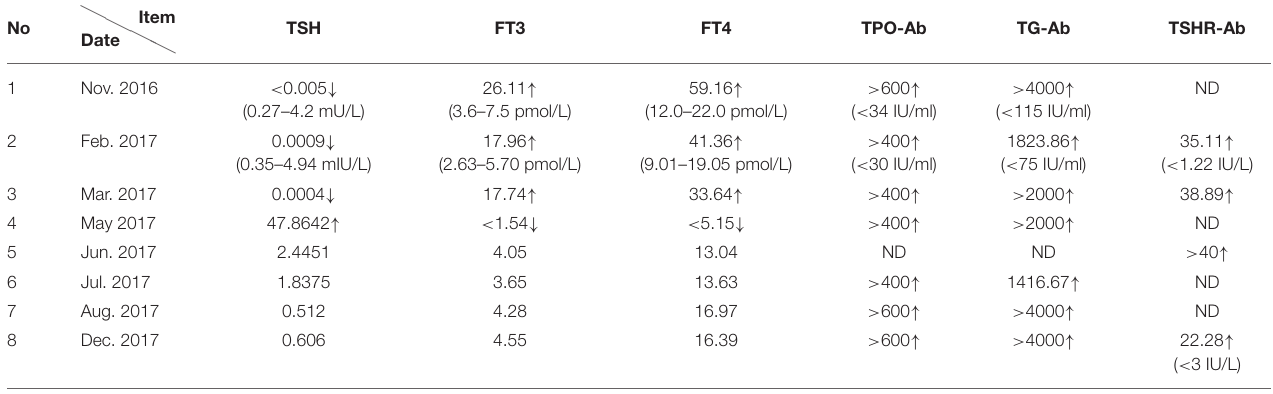
TABLE 1 | Changes in thyroid function results from the beginning to the last follow-up. No